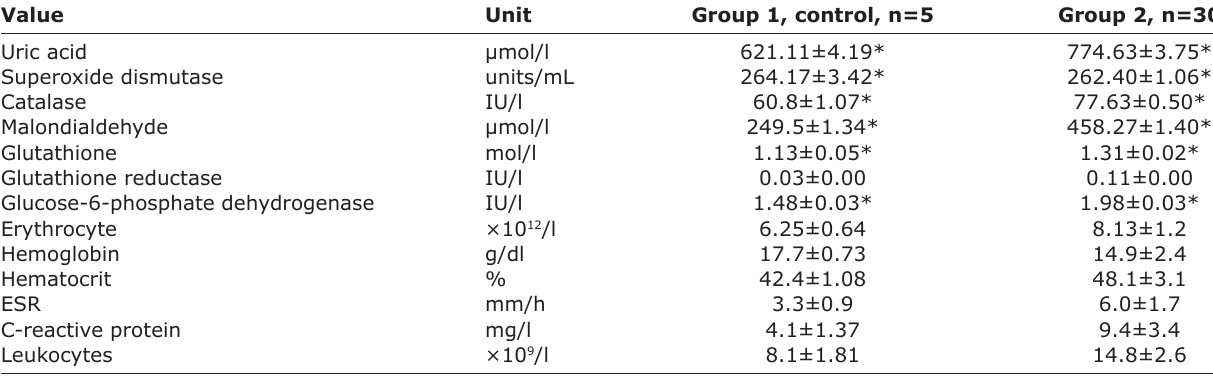
Table-3: Changes in the level of lipid peroxidation in dogs on the 14 th day of the study, M±m. Value